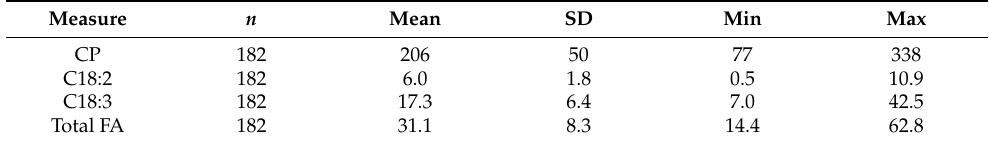
Table 2. Crude protein (CP), linoleic acid (C18:2), α -linolenic acid (C18:3), and total fatty acids (Total FA) content (g kg − 1 ) in forage grasses, legumes, and forbs in the combined dataset (12, 18, 26, 28, 37, 38). Measure n Mean SD Min CP 182 182